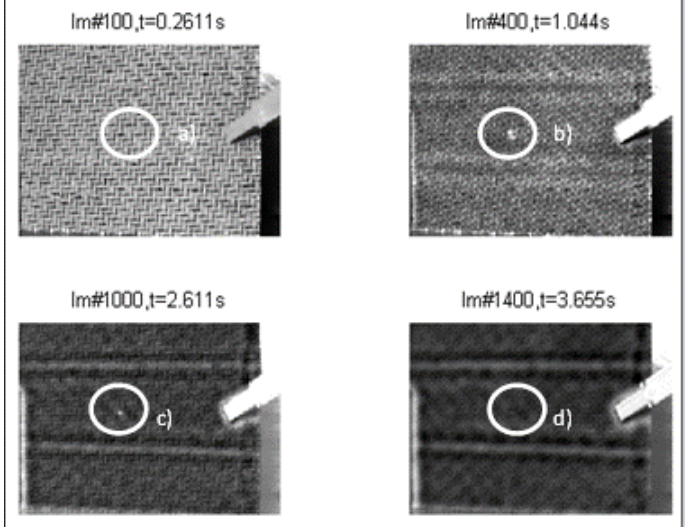
Figure 11. Thermography analysis after impact testing at 4 J, the second derivative of